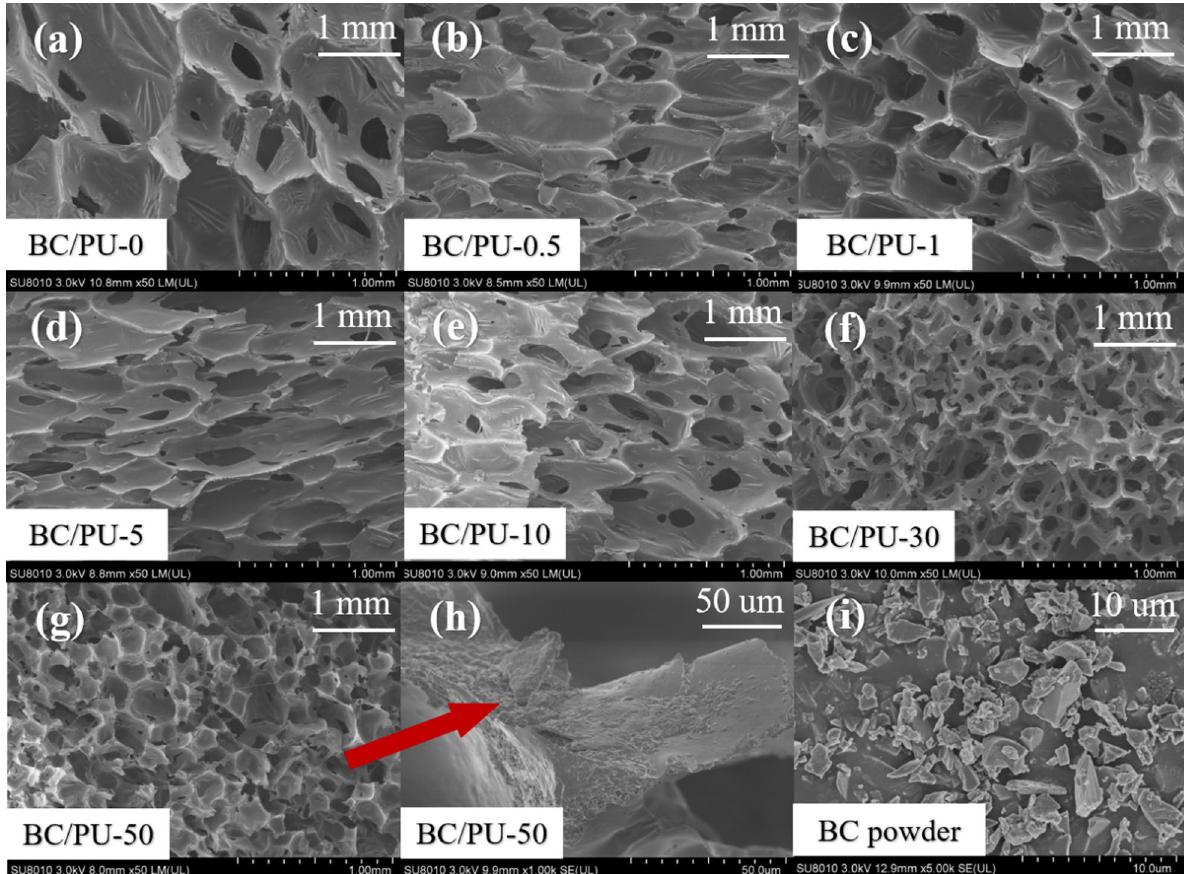
Fig. 1 SEM images of BC/PU-0 ( a ), BC/PU-0.5 ( b ), BC/PU-1 ( c ), BC/PU-5 ( d ), BC/PU-10 ( e ), BC/PU-30 ( f ), BC/PU-50 ( g ), BC/PU-50 ( h , × 1000) and BC powder